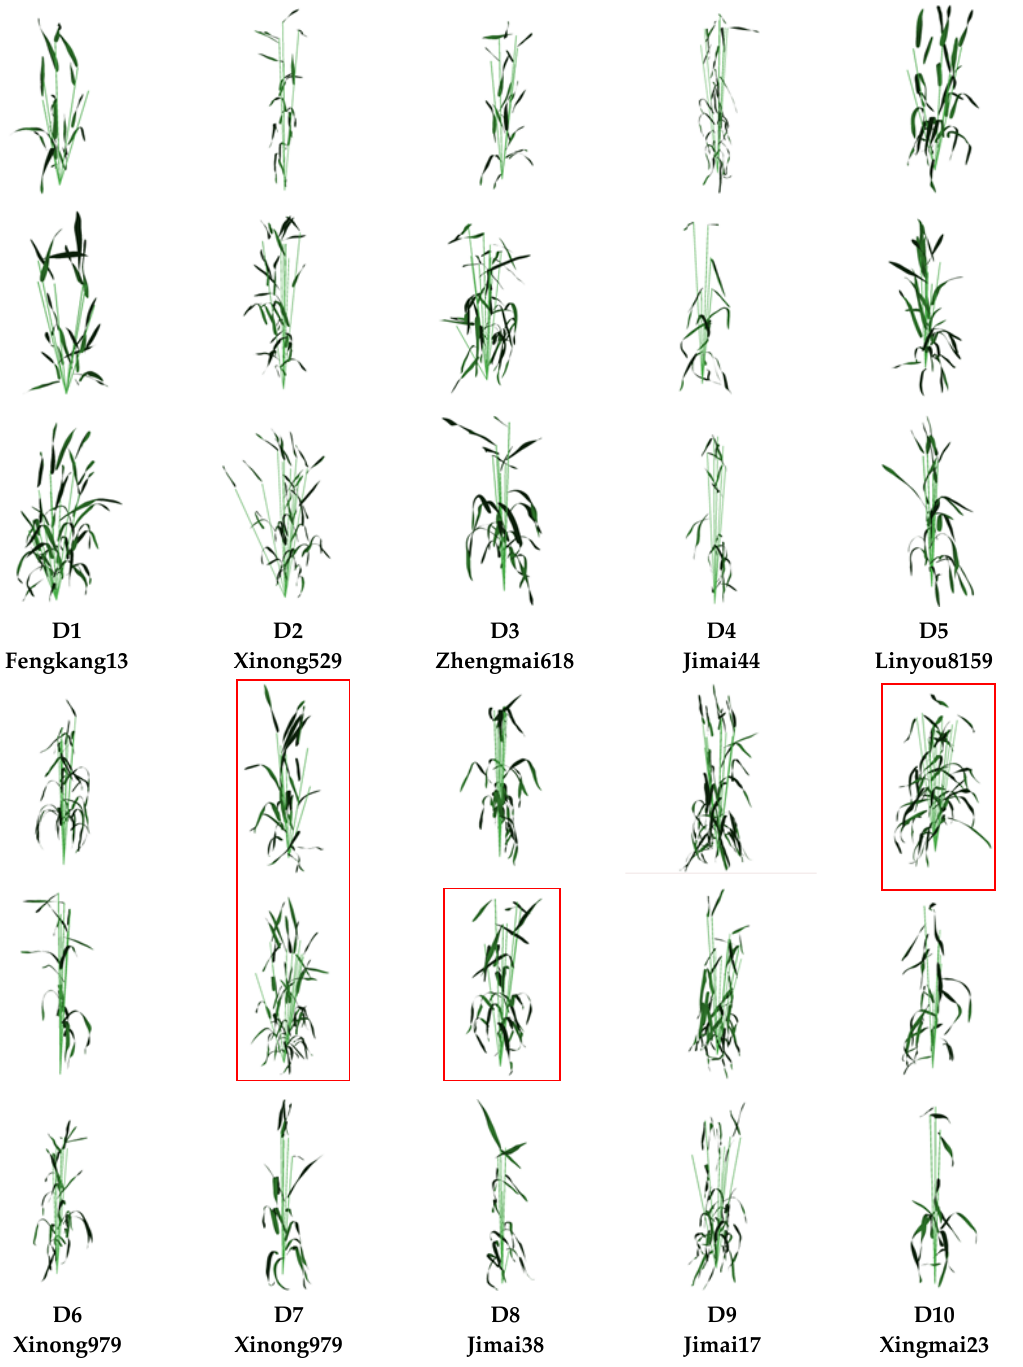
Figure 5. Modeling results of 10 wheat cultivars. The red boxes indicate wheat plants that are not coincident to plant architecture variation.